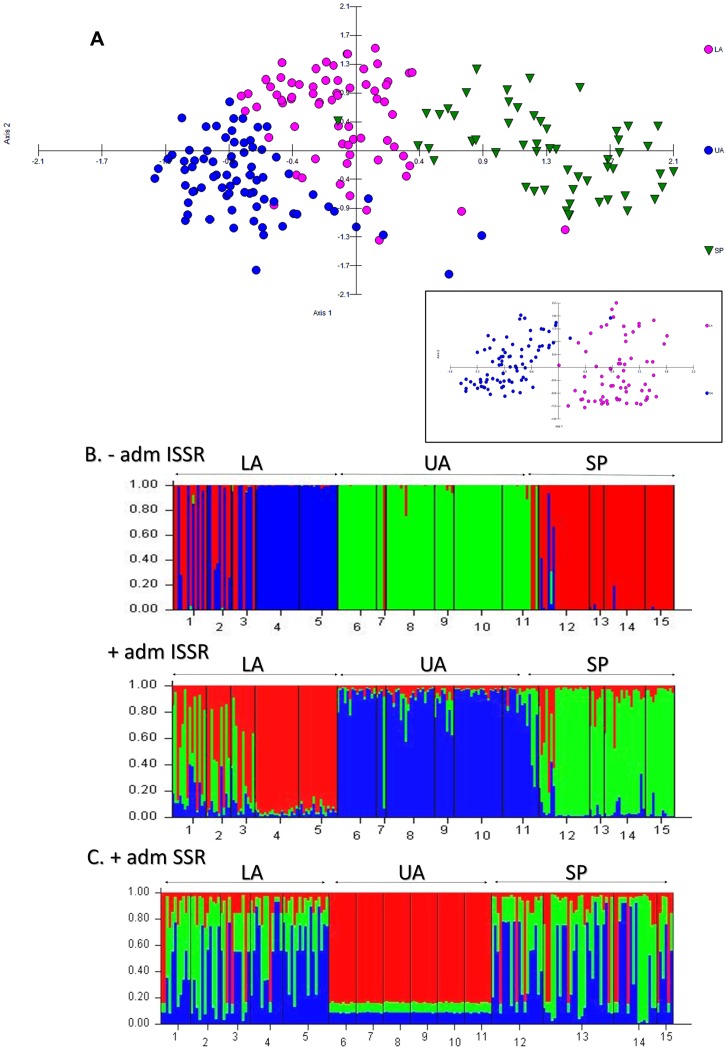
Analyses of sampled populations using PCO and STRUCTURE.Genetic relationships were determined using (A) PCO analyses of 207 ISSR fingerprints obtained for fifteen populations collected from 3 regions. Designations for regions are: Upper Assam or UA (cultivated populations), Lower Assam or LA (cultivated populations) and Shillong plateau or SP (wild populations). Inset shows PCO analyses of ISSR fingerprints from eleven cultivated populations from Upper Assam and Lower Assam regions. Putative population genetic structure (B) was obtained with Admixture (+adm ISSR) and without Admixture (-adm ISSR) settings at K = 3 using ISSR data with STRUCTURE [59]. Each vertical bar represents a moth distributed into 1 of K colored clusters. Populations 1 (BK), 2 (MD), 3(NB), 4 (GP) and 5 (SK) are cultivated populations from Lower Assam (LA); populations 6 (MR), 7 (DM), 8 (D), 9 (KG), 10 (TB) and 11 (LK) are cultivated populations from Upper Assam (UA); populations 12 (HA), 13 (MN), 14 (TR) and 15 (AG) are wild populations from Shillong plateau (SP). Population acronyms are expanded in Table 1. Putative population genetic structure (C) was obtained with Admixture (+adm SSR) setting at K = 3 for 15 populations (189 insects) using SSR data as above.